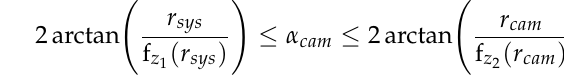
= h I 1 . For the optimal parameter values listed h I 1:2 2